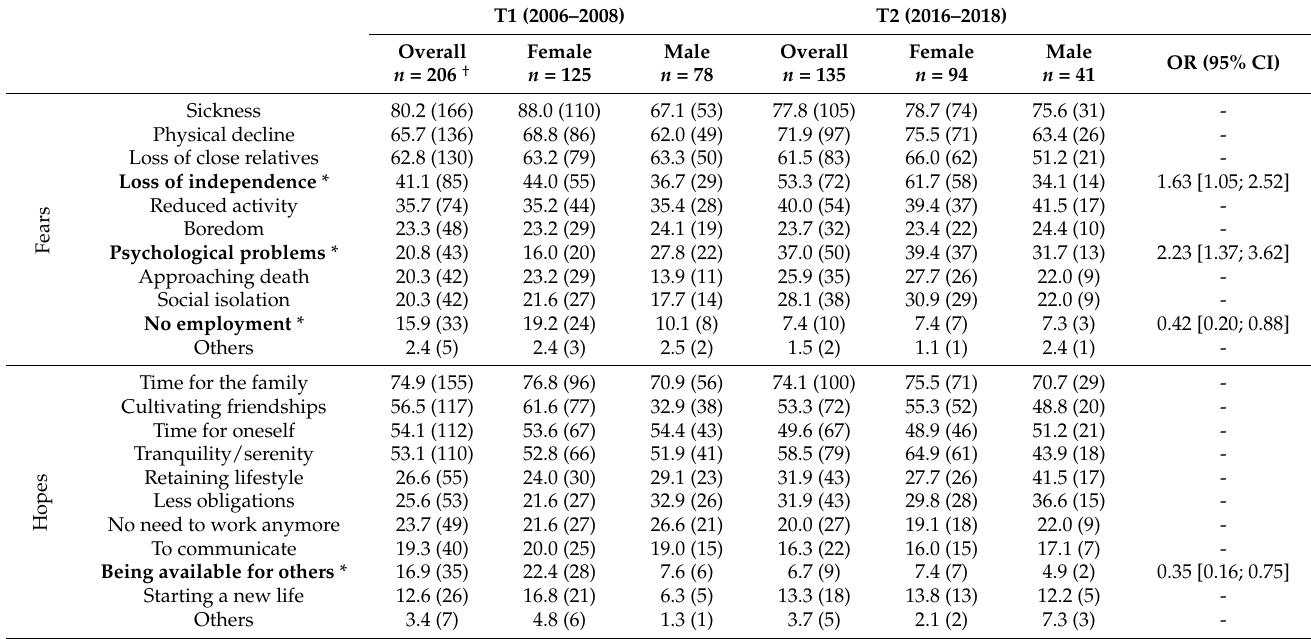
Table 2. Percentage (count) of changes in fears and hopes (modified according to Roux [16]) related to old age between T1 (2006–2008) and T2 (2016–2018) for all students and divided by sex (Chi-square test); † N (overall) = 206; sex was not reported by three participants; significant differences between T1 and T2 are presented in bold * and odds ratios (OR) including the 95% confidence intervals (CI) are